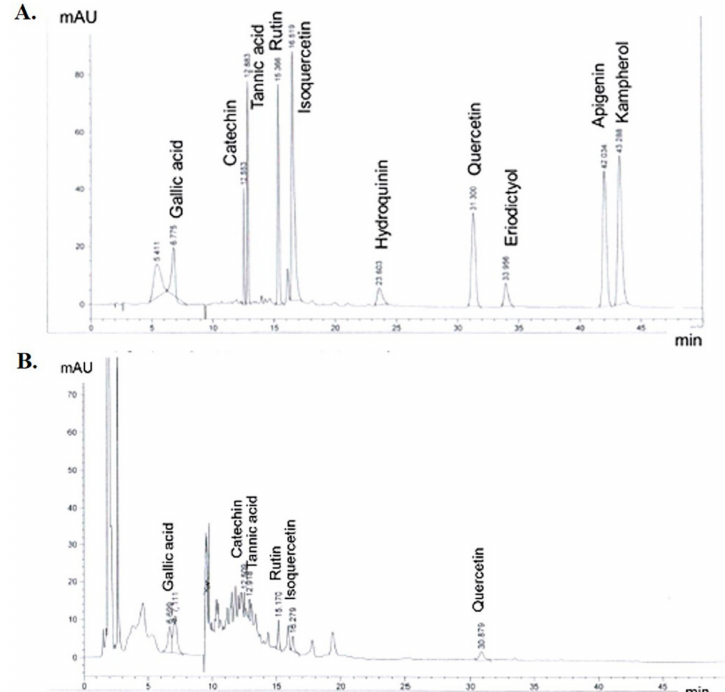
Figure 1. A representative LC-MS chromatogram of ( A ) the standards of the phenolic compounds, and ( B ) gallic acid, catechin, tannic acid, rutin, isoquercetin, and quercetin contained in Caulerpa lentillifera extract (CLE).